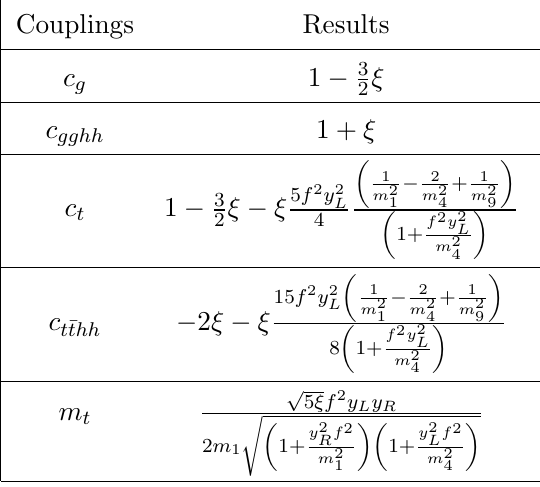
Table 6 . Higgs Couplings and top mass in MCHM of 14 + 1 Representation, which means t L is embedded in the 14 of SO(5) while t R is a